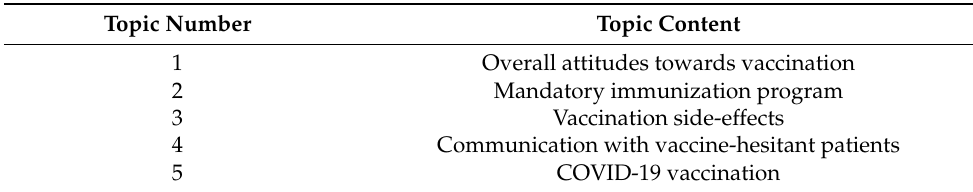
Table 2. The focus group discussion